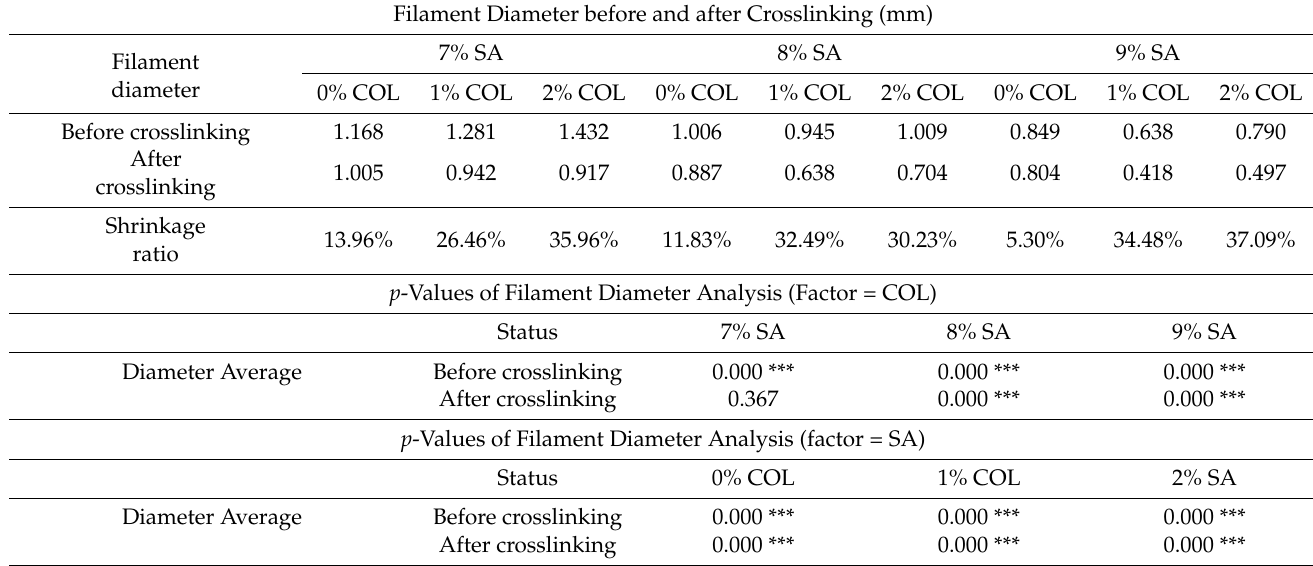
Table 1. Statistical analyses for filament